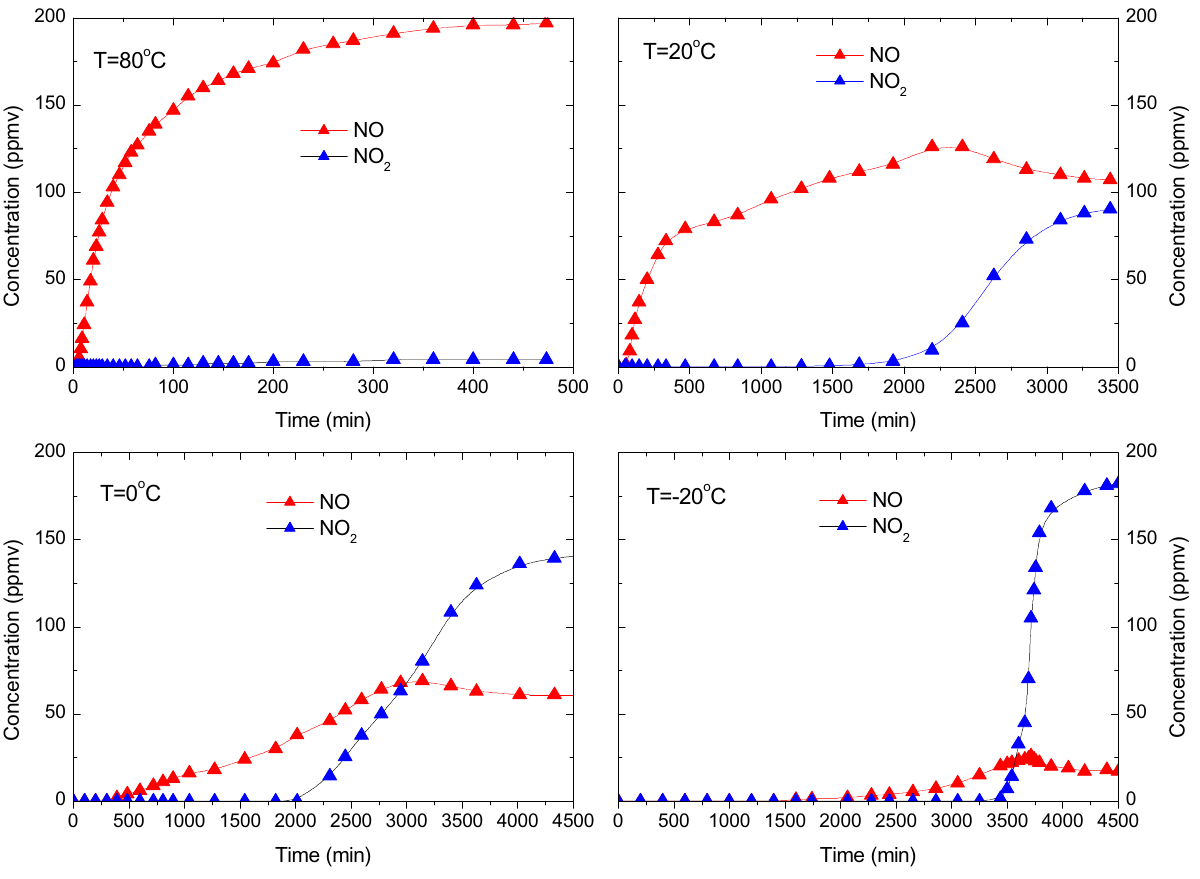
Figure 7. Breakthrough curves of NO (red) and NO 2 (blue) during NO–O 2 co-adsorption at 80, 20, 0 and – 20 ℃ (NO = 200 ppmv, O 2 = 6 vol.%, space velocity = 5000 h −1